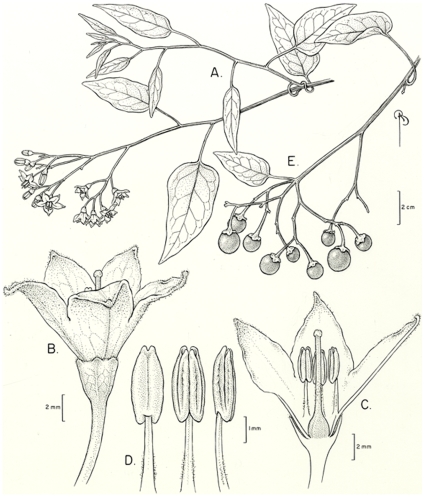

Solanum sousae.A) portion of stem with flowering inflorescence, B) flower, C) flower cross section, D) anthers, E) portion of stem with fruiting inflorecence. A–D drawn from Ventura 2212, E from Maya J. 3938.